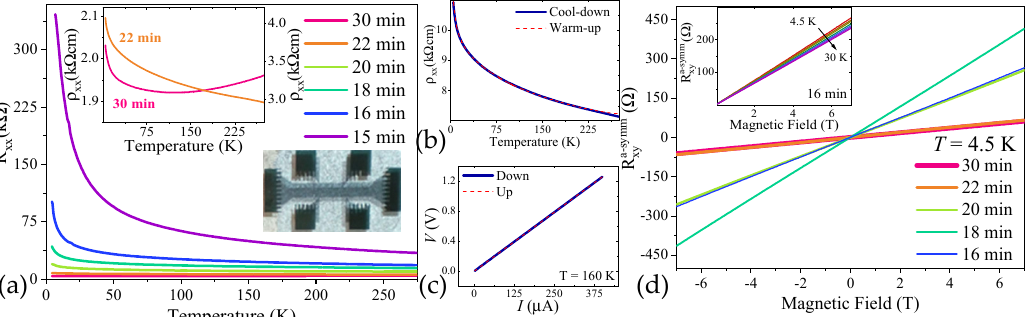
Figure 3. ( a ) Temperature-dependent resistivity of samples with different thicknesses. Left inset: behavior of the samples grown during 30 and 22 min. Right inset: optical image of a typical Hall bar used for magneto-electric transport measurements with a length and width of 820 μ m and 410 μ m, respectively. ( b ) Temperature-dependent resistivity during the cool-down and warm-up. ( c ) An exemplary I-V measurement taken at 160 K. ( d ) Hall resistance as function of perpendicular applied magnetic field. Inset: temperature-dependent Hall measurements corresponding to the VTe 2 sample grown during 16